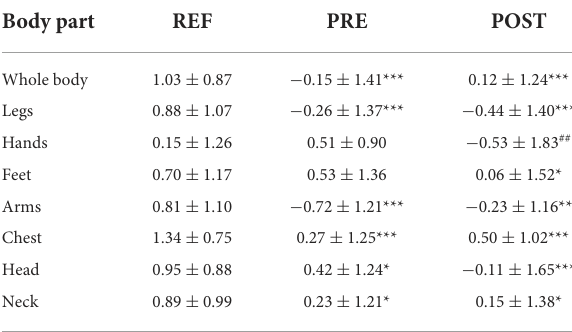
TABLE 2 Mean thermal sensation from an analog seven-point scale according to body parts. Body part